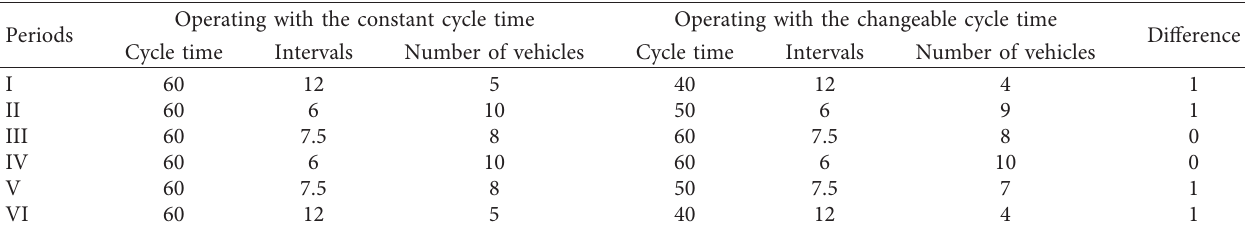
Table 10: Comparative analysis of the necessary number of vehicles for the existing duration of the cycle, as well as during the cycle time obtained in the